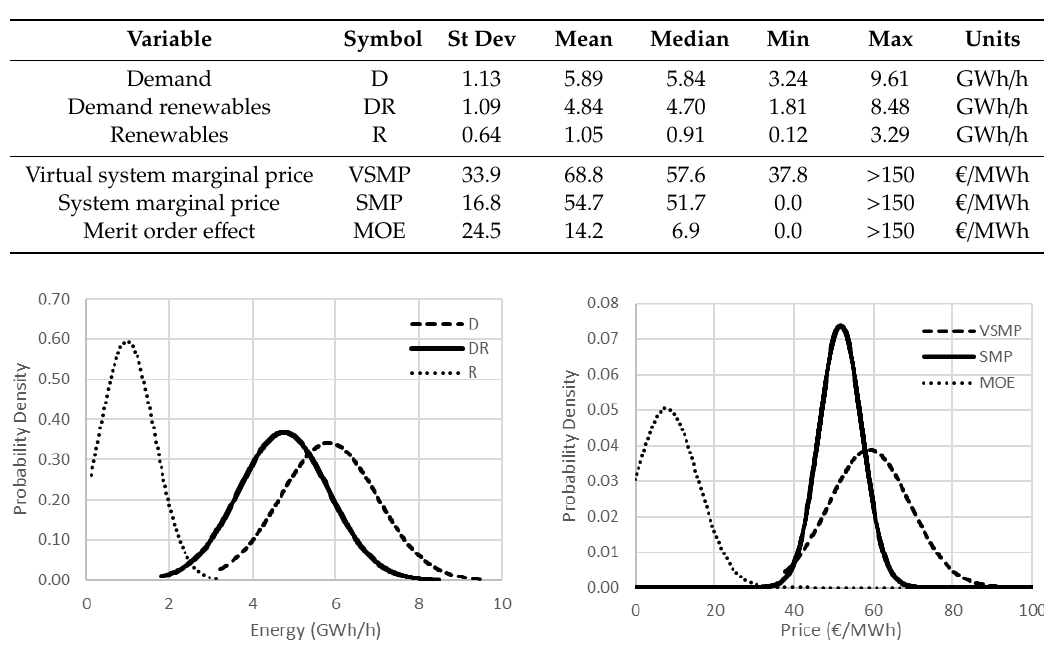
Figure 4. Fitted normal distribution: D = demand, DR = demand renewables, R = renewables, VSMP = virtual system marginal price, SMP = system marginal price, MOE = merit order effect.